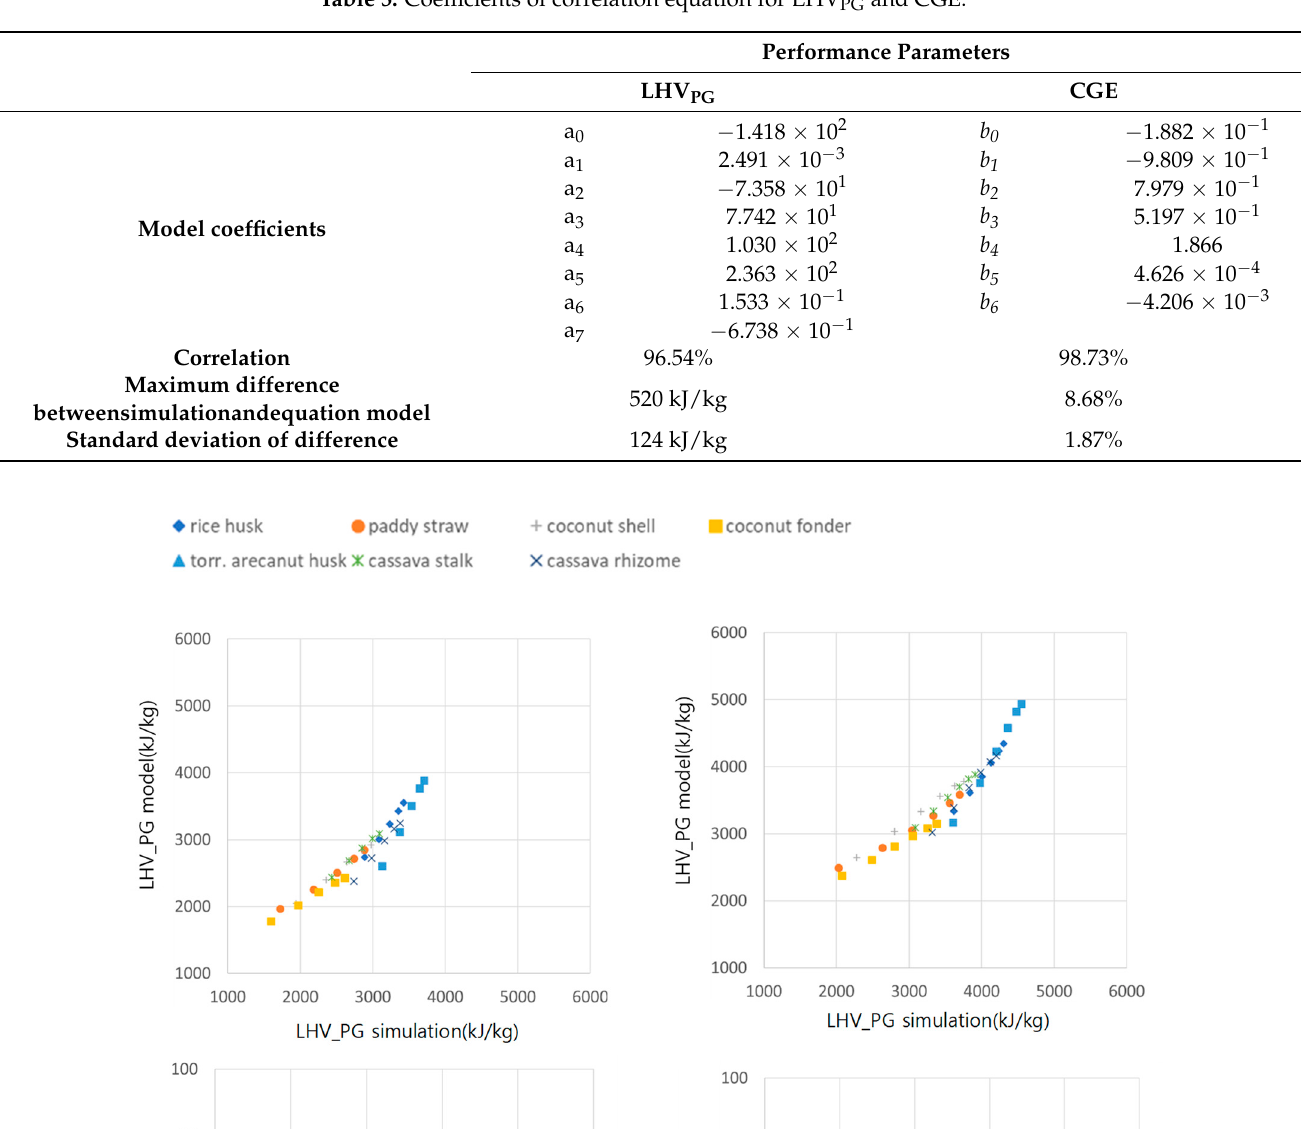
Table 5. Coefficients of correlation equation for LHV PG and CGE.